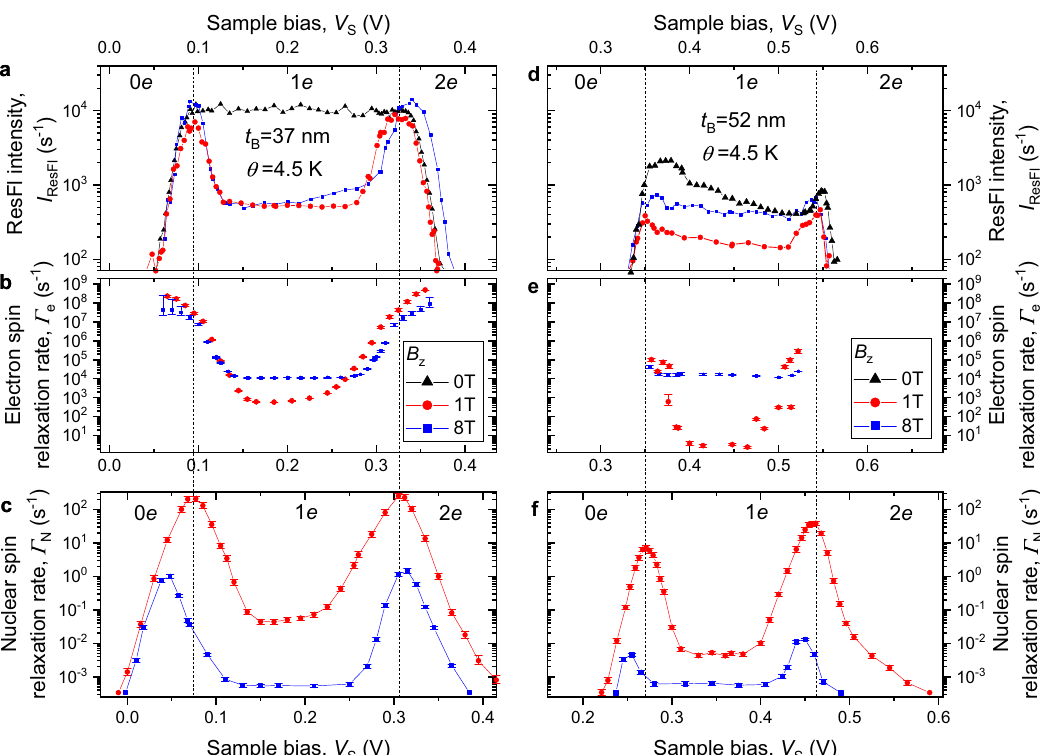
Fig. 2 Bias dependence of electron and nuclear spin dynamics. a Bias dependence of resonance fl uorescence (ResFl) intensity I ResFl in a QD sample with t B = 37 nm. At B z = 0 T (triangles) a clear Coulomb blockade (1 e plateau) is observed, with I ResFl decreasing when the dot is emptied (0 e , V S ≲ 0.1 V) or fi lled with a second electron (2 e , V S ≳ 0.33 V). At non-zero B z = 1 T (circles) and B z = 8 T (squares) the centre of the 1 e plateau is suppressed due to spin ‘ shelving ’ , leaving two peaks arising from resonant tunnel coupling to the Fermi reservoir. b Bias dependence of the electron spin relaxation rate measured at B z = 1 T (circles) and B z = 8 T (squares). c Bias dependence of the nuclear spin relaxation rate measured for the same QD as in a and b . Note the offset in the horizontal axis, which is likely due to additional electric fi elds arising from the optically generated trapped charges near the QD. Vertical dashed lines separate different charge states 0 e , 1 e , 2 e . d – f Same as a – c but for a QD from a thick-barrier sample ( t B = 52 nm). All error bars are 95% con fi dence